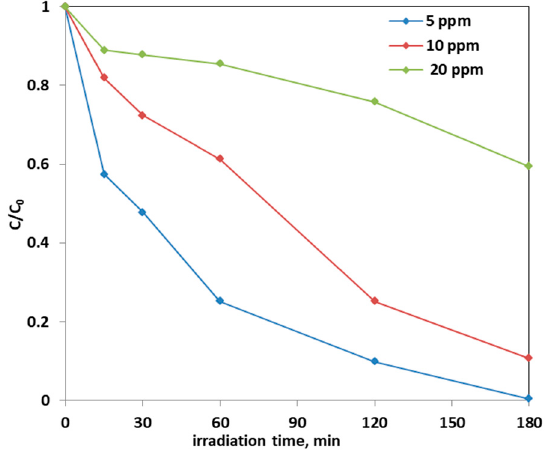
Figure 14. Photocatalytic discoloration of AO7 solution with 0.3 g of optimized Fe(2.5)-TiO 2 pho- tocatalyst changing the AO7 initial concentration under visible light irradiation.